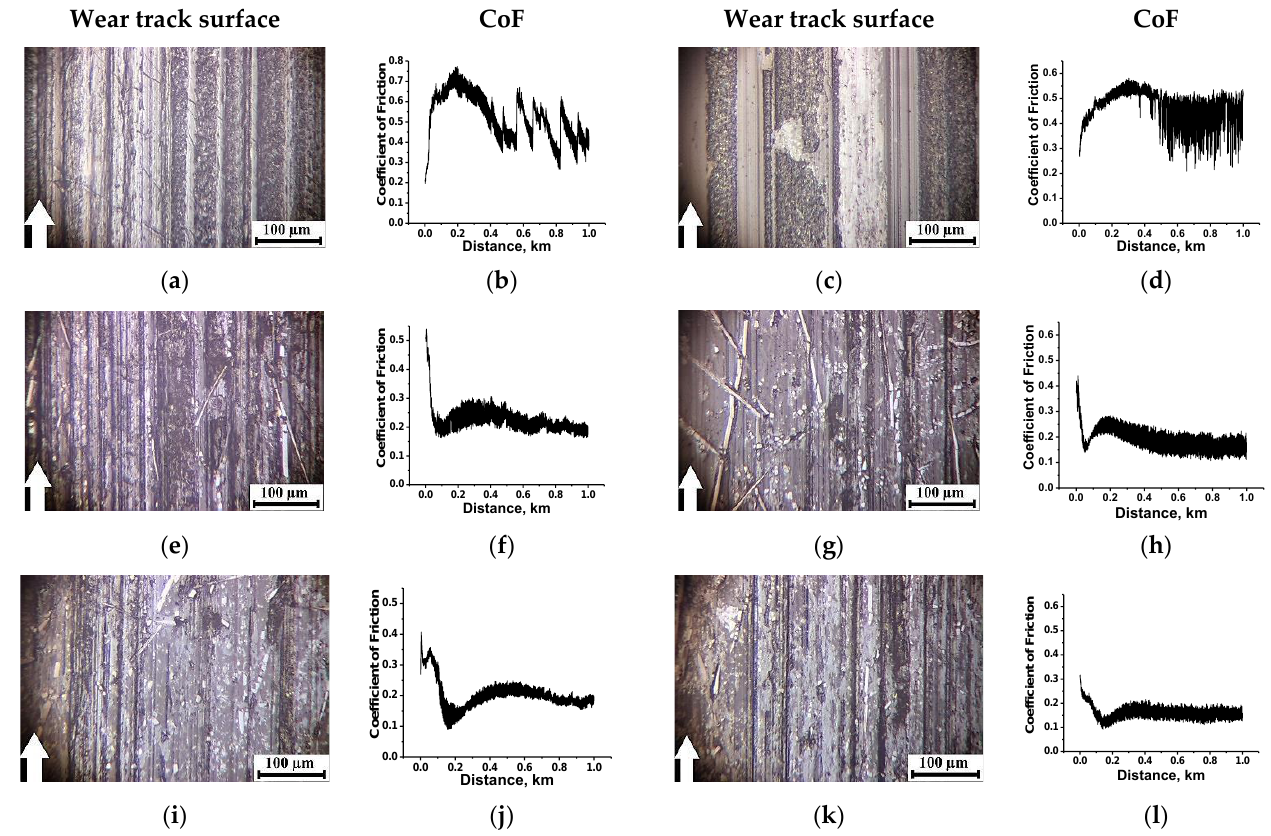
Figure 6. The optical micrographs of the wear track surfaces and the CoF time dependences for both neat PI ( a , b ) and PEI ( c , d ), as well as their PI/10CCF ( e , f ), PI/10CCF/10Gr ( i , j ), PEI/10CCF ( g , h ), PEI/10CCF/10Gr ( k , l ) composites. The metal-polymer tribological contact under the ‘severe’ conditions ( P = 180 N, V = 0.5 m/s). See Figure S4 for more details.